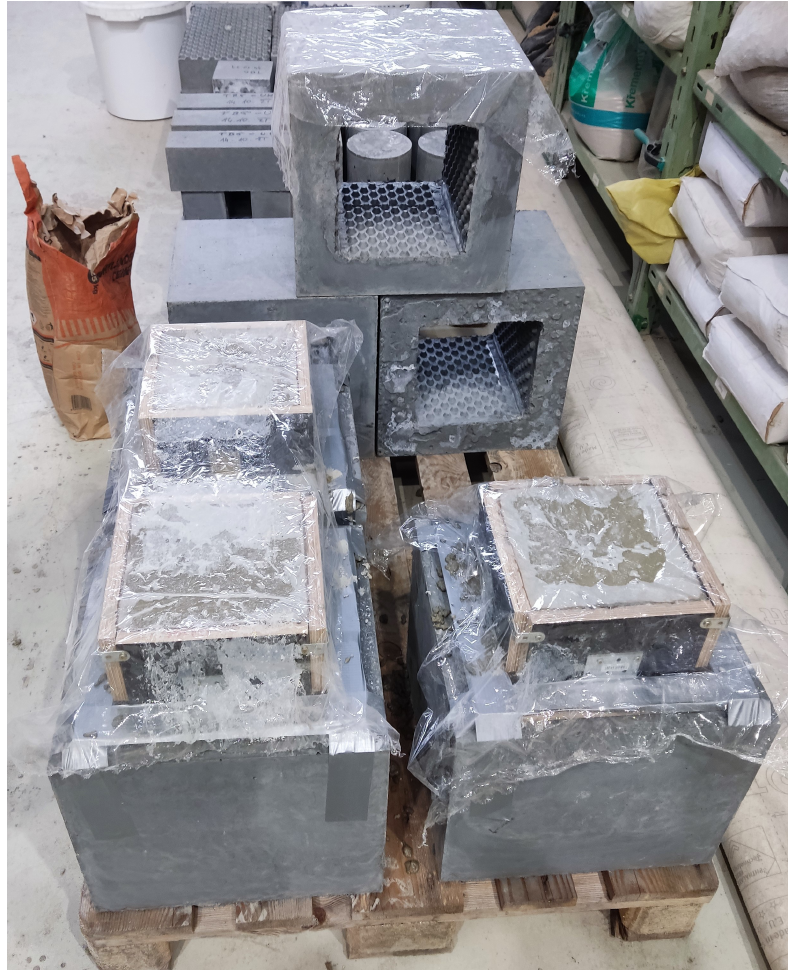
Figure 7. In the front section are box samples for testing of the interaction between UHPC and NSC1; behind them are parts of samples made from UHPC with buttons on the inner surface prepared to be filled with NSC2 with